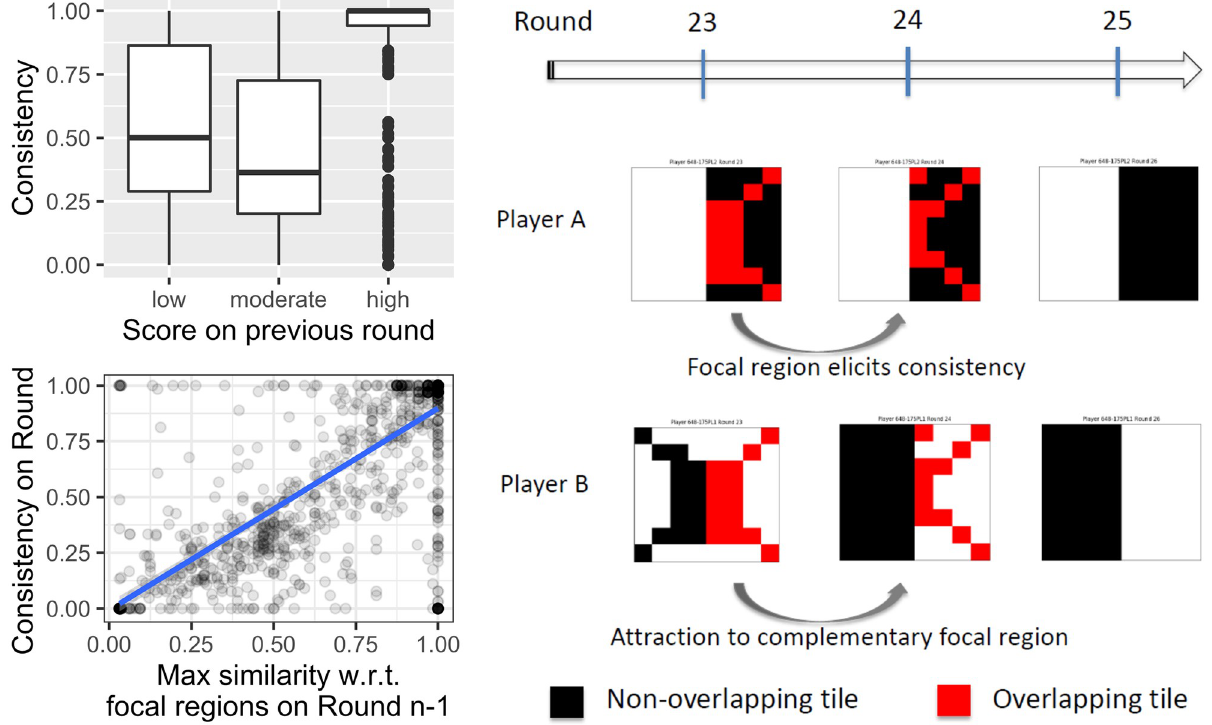
Fig 5. Evidence of bounded-rationality heuristics. Top left panel: Boxplot of consistency for three different levels of score on the previous round. Bottom left panel: Regression of consistency with respect to maximum similarity to a focal region on the previous round. In both panels, each data point represents a trial ( N = 1134). Right panel: Transition from one round to the next, taken from an actual gameplay. In each grid, black tiles represent tiles uncovered by one player and red tiles were uncovered by both players. Player A’s transition illustrates ‘stubbornness’ and Player B’s illustrates the attraction exerted by the complement of A’s focal region, which is also a focal region. See details in the text.